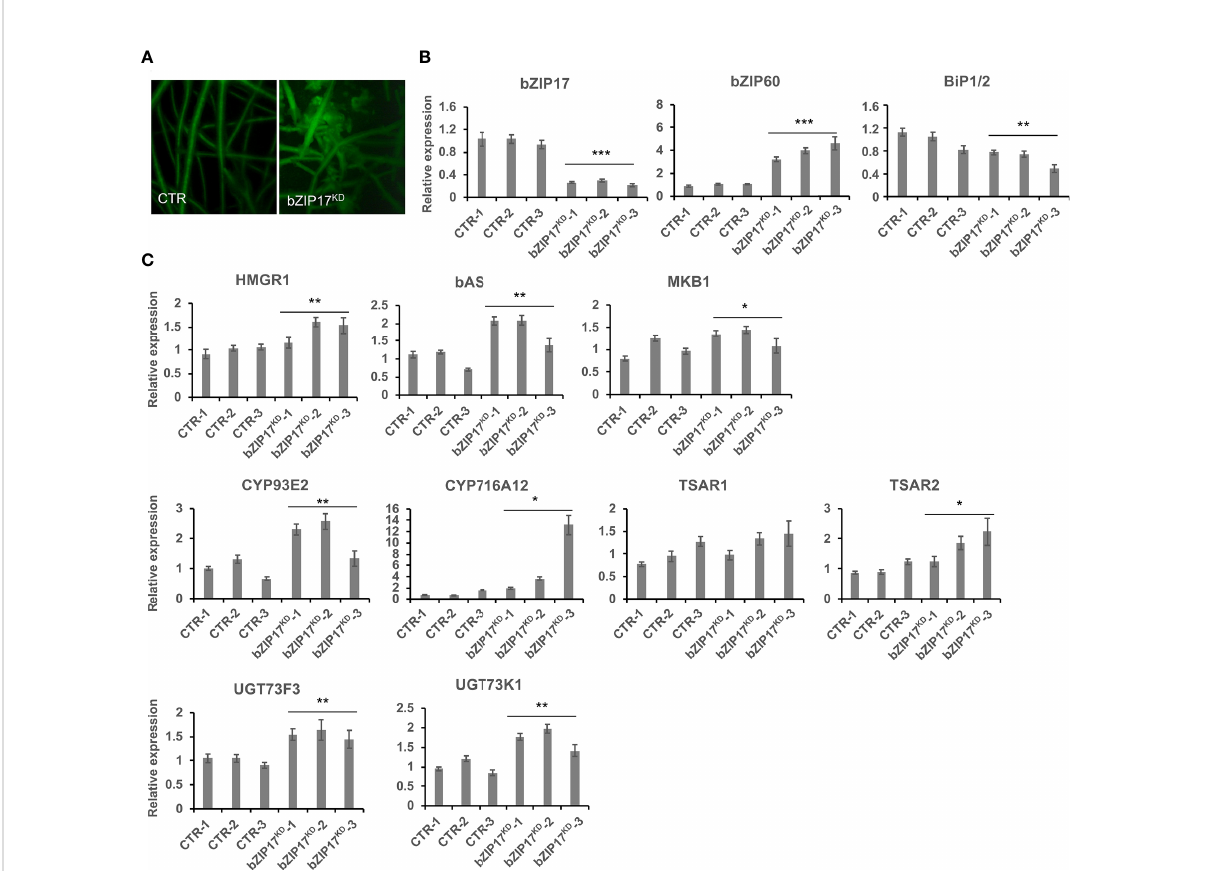
FIGURE 4 Silencing of bZIP17 slightly increases TS biosynthesis gene expression in M. truncatula hairy roots. (A) Morphology of control (CTR) and bZIP17 KD hairy roots. (B, C) qRT-PCR analysis of bZIP17 , bZIP60 , BiP1/2 genes (B) and TS biosynthetic genes (C) in three independent CTR and bZIP17 KD hairy root lines. Values in the y-axis represent the expression ratio relative to the normalized transcript levels of CTR lines. The error bars designate SE (n = 3, technical repeats). Statistical signi fi cance was determined by a Student ’ s t -test (*P < 0.05, **P < 0.01, ***P <